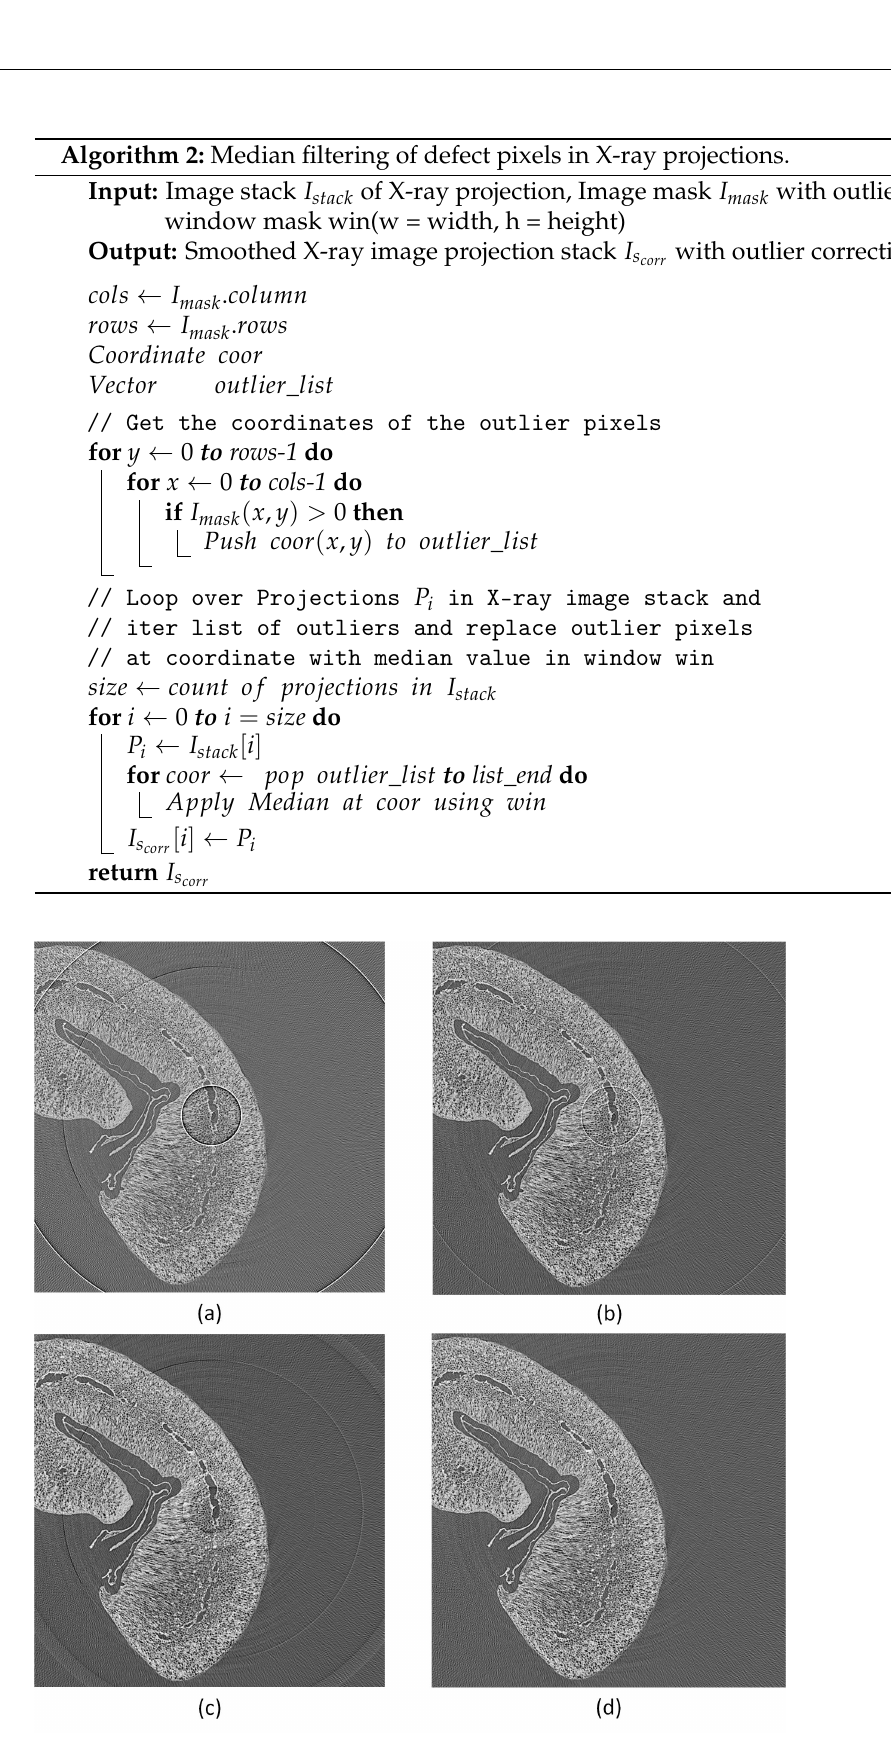
Figure 4. Tomogram of a coffee bean. Applying outlier and ring artifact reduction methods: ( a ) without any corrections (two to three bad pixels next to each other cause severe ring artifacts); ( b ) with MF method only; ( c ) with DLR correction only; ( d ) with MF and DLR method